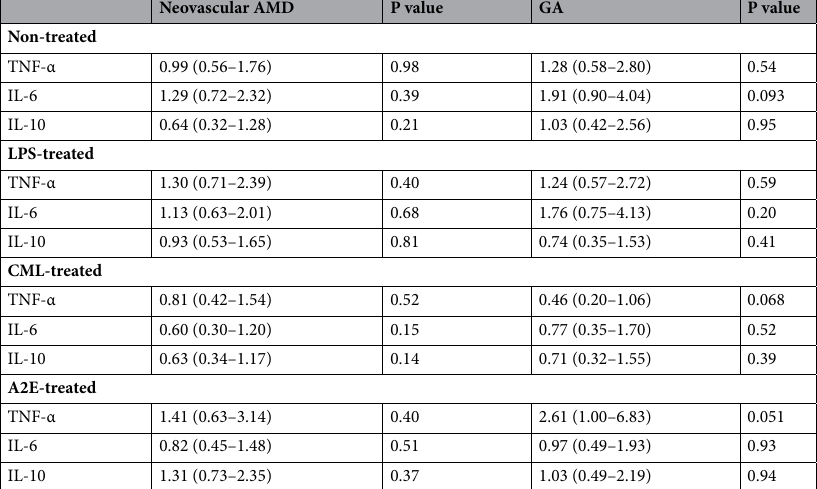
Table 3. Fold increase of cytokine expression in patients with neovascular AMD and geographic atrophy (GA) as compared controls for different stimulation conditions. Data are presented as estimated odds ratios adjusted for age and sex per incremental increase in Z-score of cytokine expression with 95% confidence intervals. Reference group were healthy controls. AMD age-related macular degeneration, GA geographic atrophy, LPS lipopolysaccharide, CML Nε-carboxymethyllysine, A2E N -retinyl- N -retinylidene ethanolamine, TNF - α tumour necrosis factor α, IL interleukin.